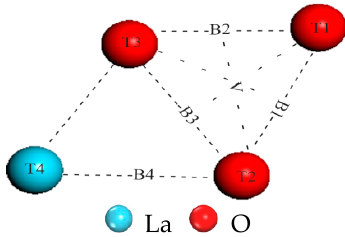
Figure 2. The initial adsorption positions for the LaNiO 3 (001)/H 2 system in Termination I.